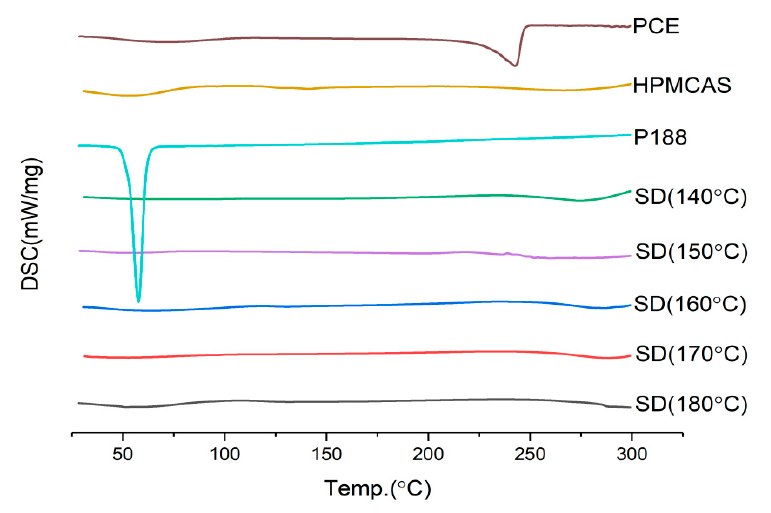
Figure 9. DSC diagram of solid dispersion prepared at different barrel temperature.